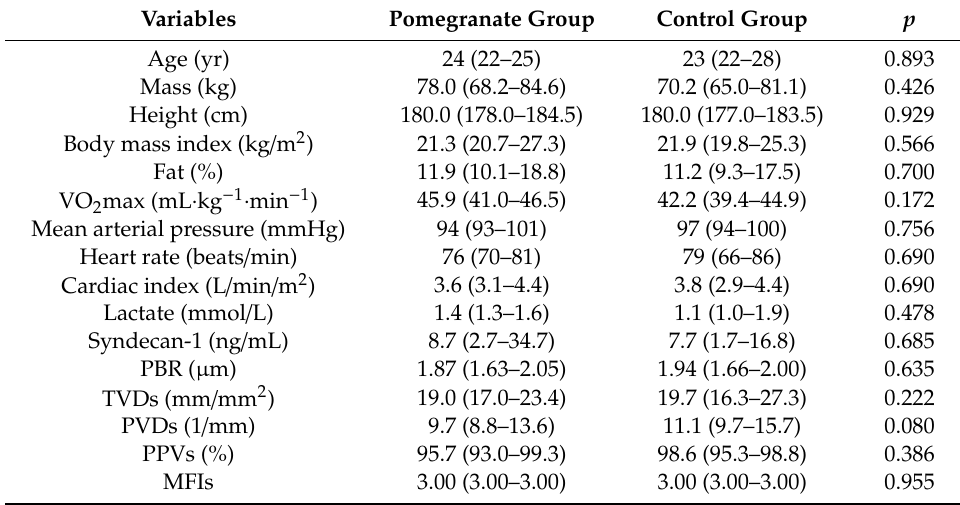
Table 1. Baseline characteristics of the study